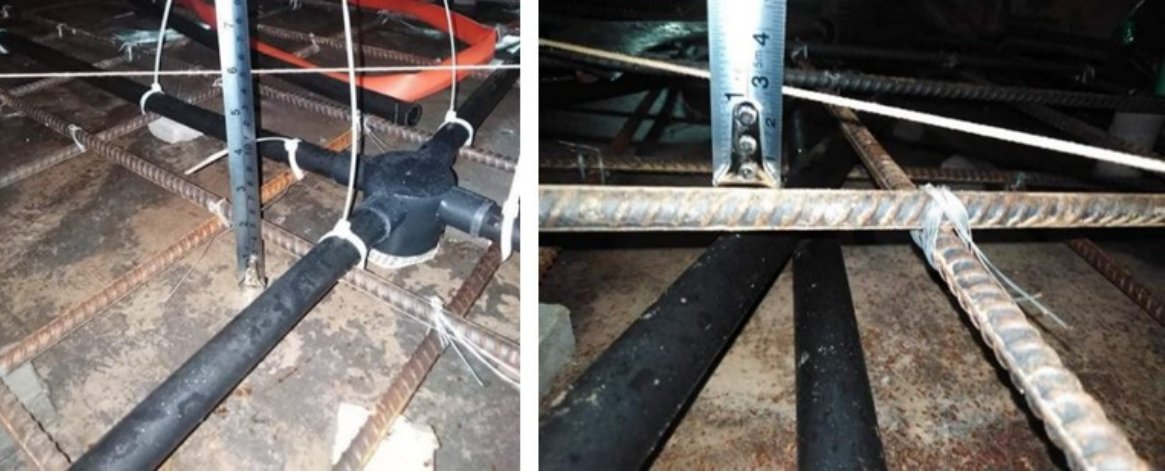
Figure 5. Checking of rebar covers in an elevated concrete slab (used with permission from Khadem [23]).